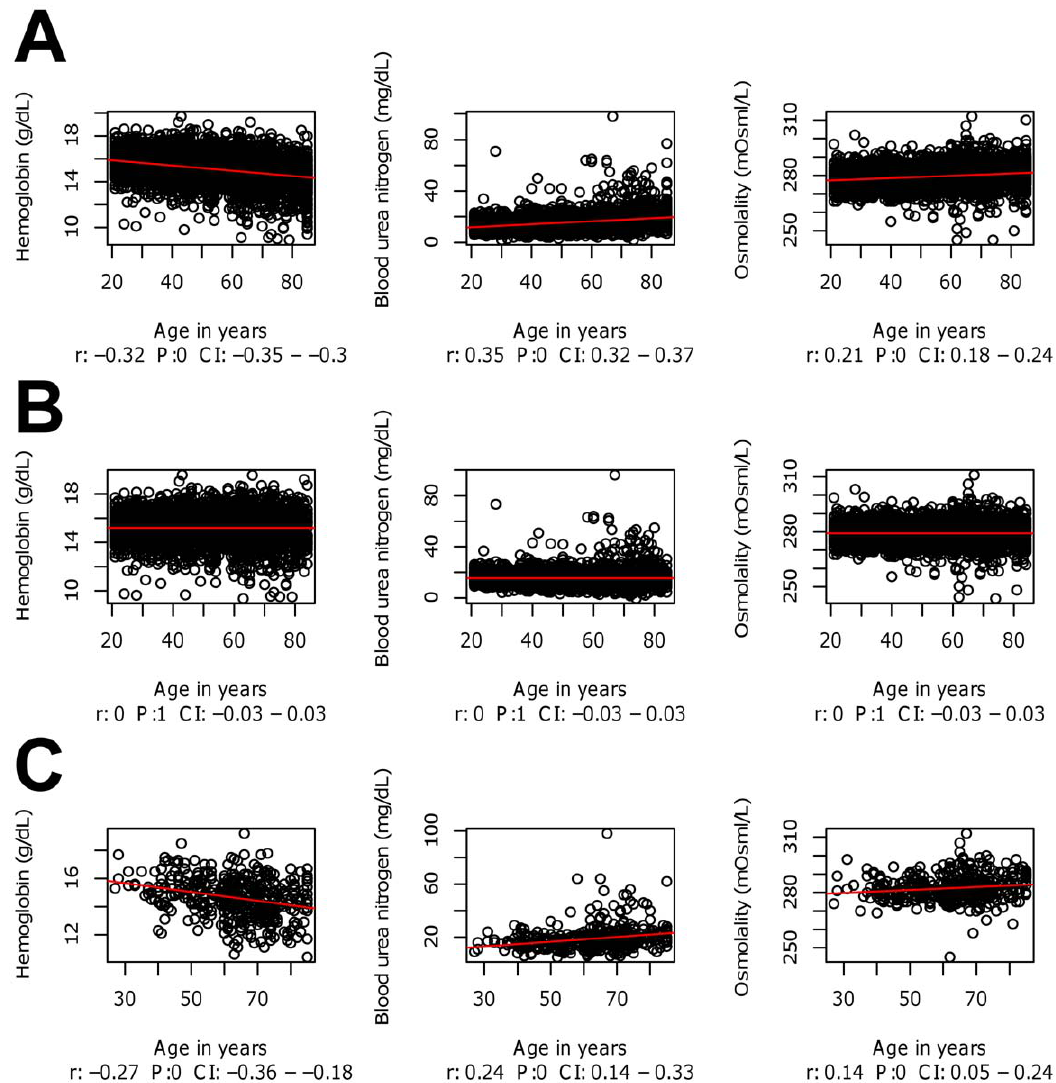
Figure 4. The correlation between selected blood markers and age. Linear regression was calculated for all biomarkers, and least square regression lines (red) were fitted for each marker. r – Pearson correlation coefficient, P – p value, CI- confidence interval of the p-value. (A) Raw data from the training set; (B) training set data after age adjustment. (C) diabetic males, raw data from the training set.